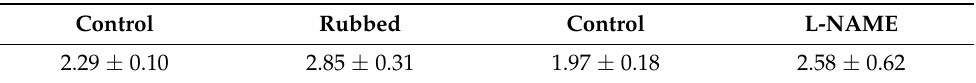
The values represent the negative logarithm of the half-maximal effective concentration (pEC 50 and pIC 50 ). The values are mean ± standard error (SEM) of 5–7 independent experiments. The aortic ring tissue was pre-incubated with L-NAME, an endothelial nitric oxide synthase inhibitor, to evaluate whether endothelial factors were released. The results show that the use of 10 − 4 M L-NAME for pre-incubation with the aortic rings significantly de- creased the vascular relaxation to 100 µ g/mL A. dentata extract concentration (Figure 5A,B). The values for 2 log µ g extract/mL (100 µ g/mL) were 44 ± 4% control versus 5 ± 3% L-NAME, p < 0.001. In addition, the values for 3 log µ g/mL (1000 µ g/mL) extract were control was not significantly different (Table 5).